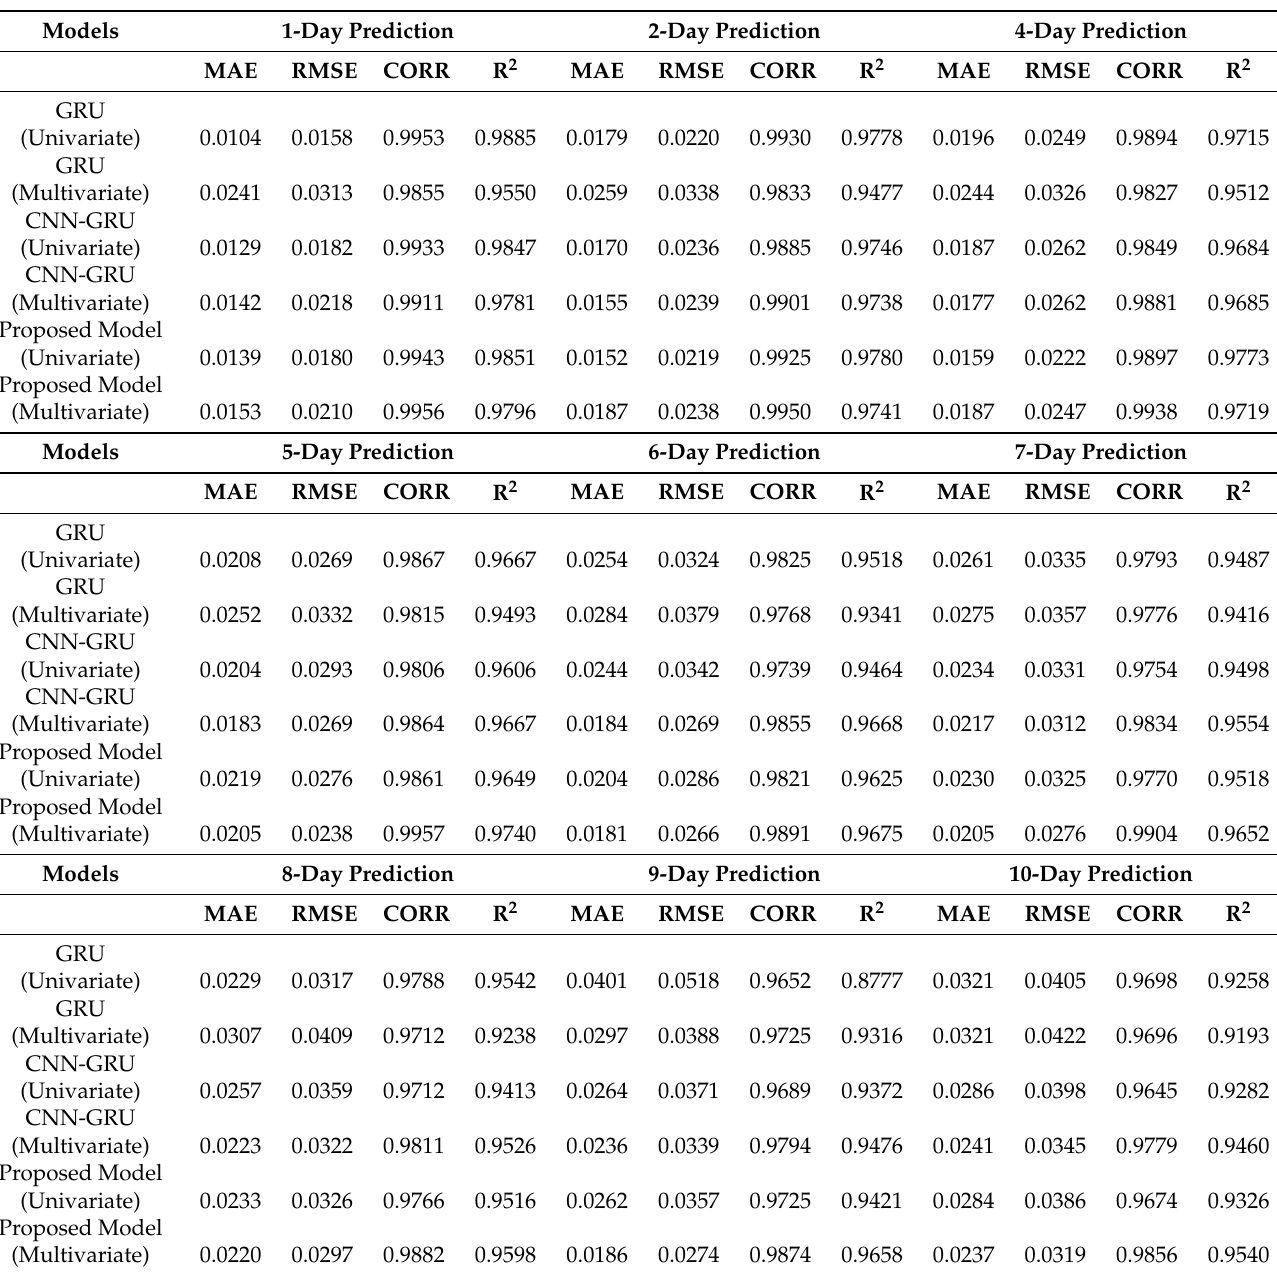
Table 2. Comparison of the performance results for GRU-based models for 1-day to 10-day predic-